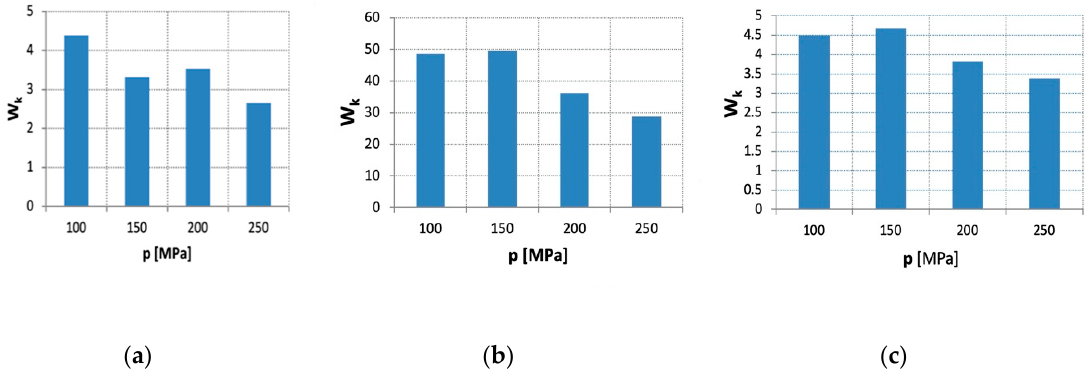
Figure 7. Values of the indicator of energy consumption benefits that result from the comminution of: ( a )—carbonate, ( b )—sandstone, ( c )—shale copper ore in a hydro-jet mill.